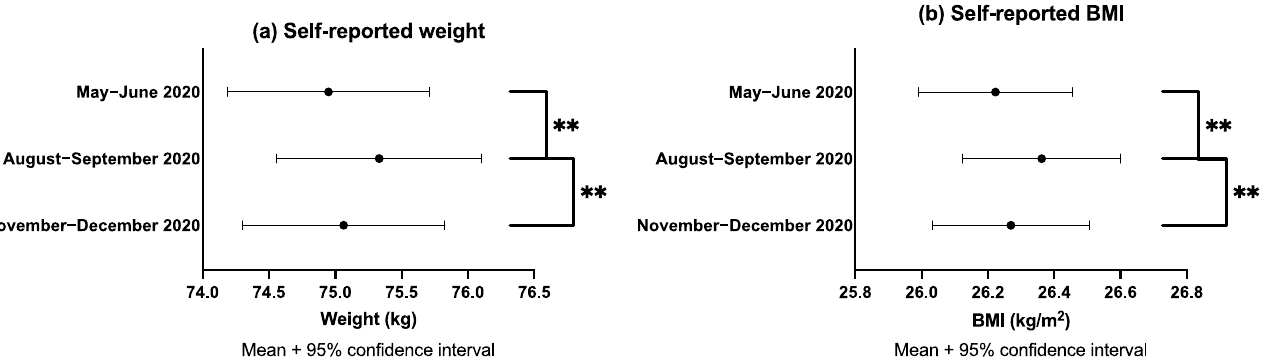
Figure 1. Means and 95% confidence intervals with pairwise comparisons between baseline (May–June 2020), 3-months pairwise comparisons between timepoints were significant at the 0.005 level.